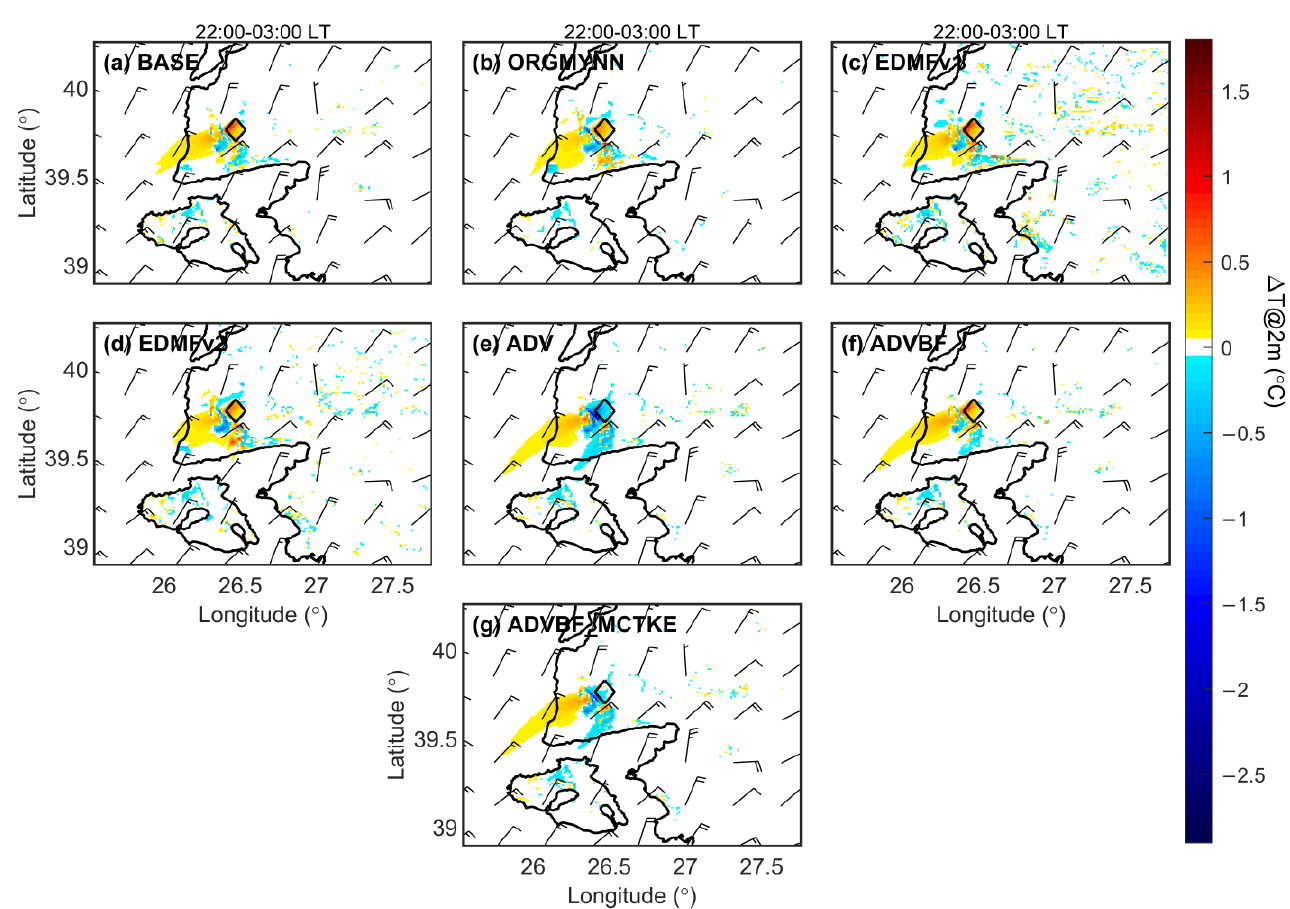
Figure 11. Same as in Figure 6, but for near-surface air